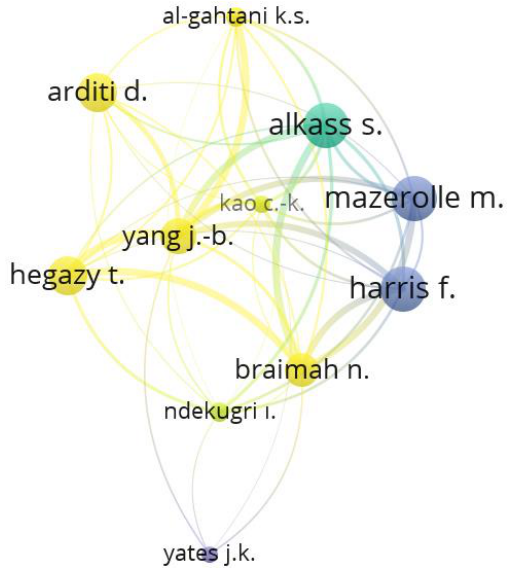
Figure 5. Magnitudes of the published documents as per the authors. The colours represent the average years concerning the publications. While the authors highlighted in yellow stand for the authors who published more updated documents compared to the others, colours, namely green, blue and purple indicate the authors with relatively older contributions to the field of the delay analysis, respectively.